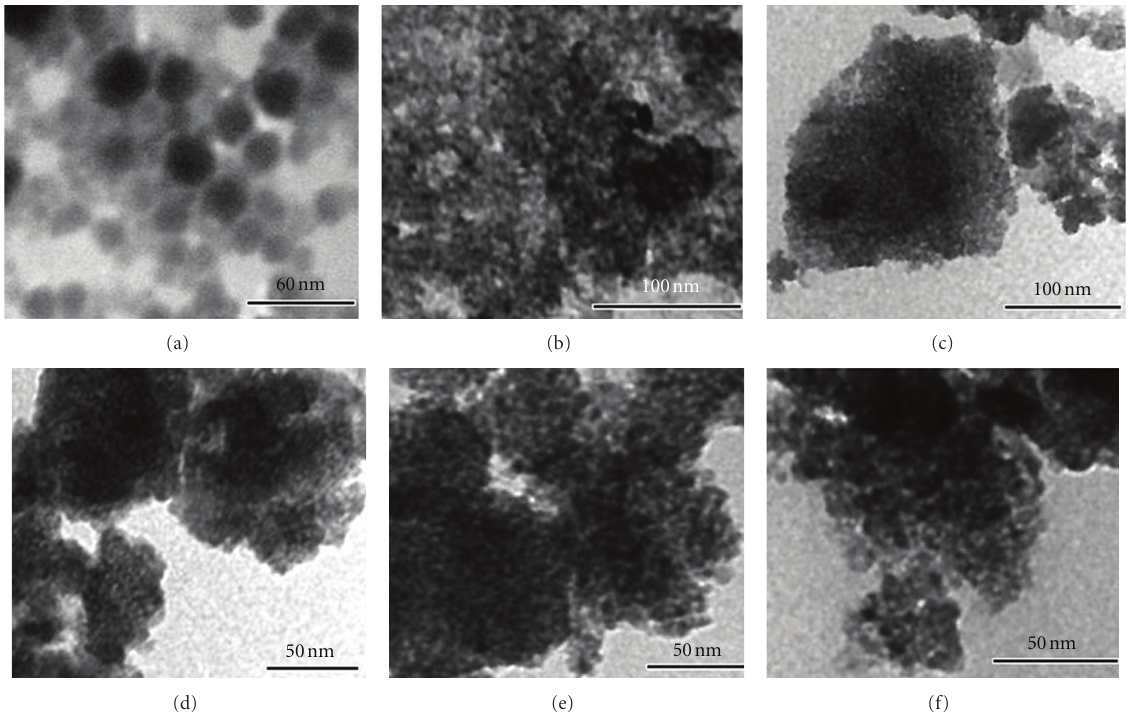
Figure 2: TEM images of the precursor of (I 2 ) n -sensitized nanoporous TiO 2 (a), and IT-T calcined for 3h at (b) 200 ◦ C; (c) 300 ◦ C; (d) 400 ◦ C, (e) 500 ◦ C and (f) 600 ◦ C.